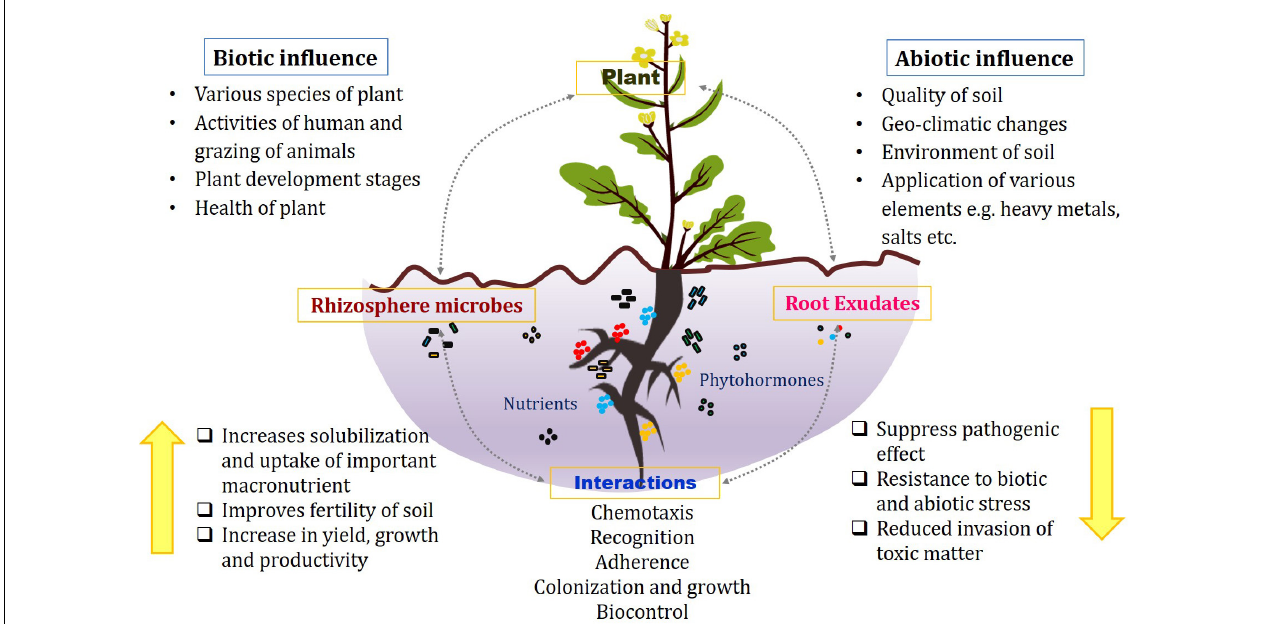
FIGURE 1 | Associations in the rhizosphere between plant roots, microbes, and root exudates under biotic and abiotic influences.